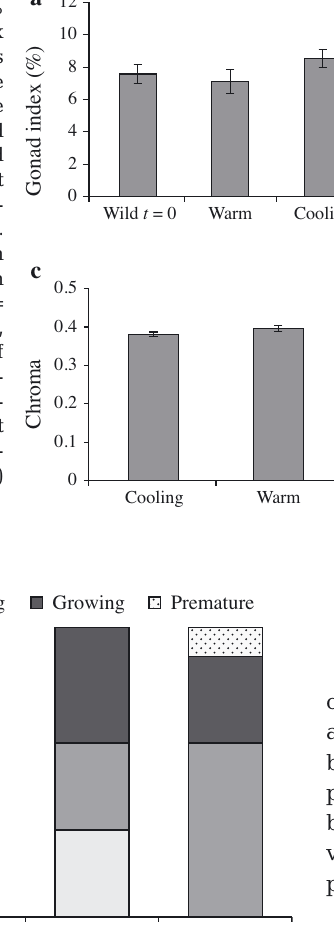
8.2, p < 0.001). The mean GI of WARM ur chins was 22% lower than the wild urchins (GI: 9.2 ± 0.4%; p < 0.05), while there was no difference in GI between wild and COOLING urchins (p > 0.05; Fig. 6a).